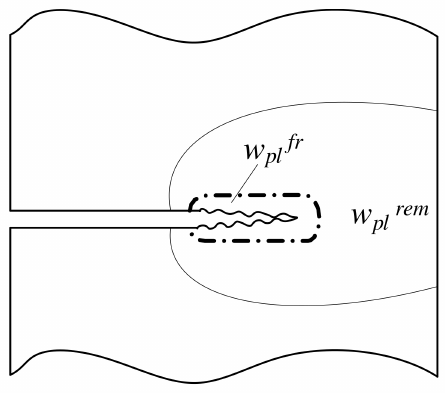
Figure 1. Different energy dissipation regions: fracture, local plasticity, and remote